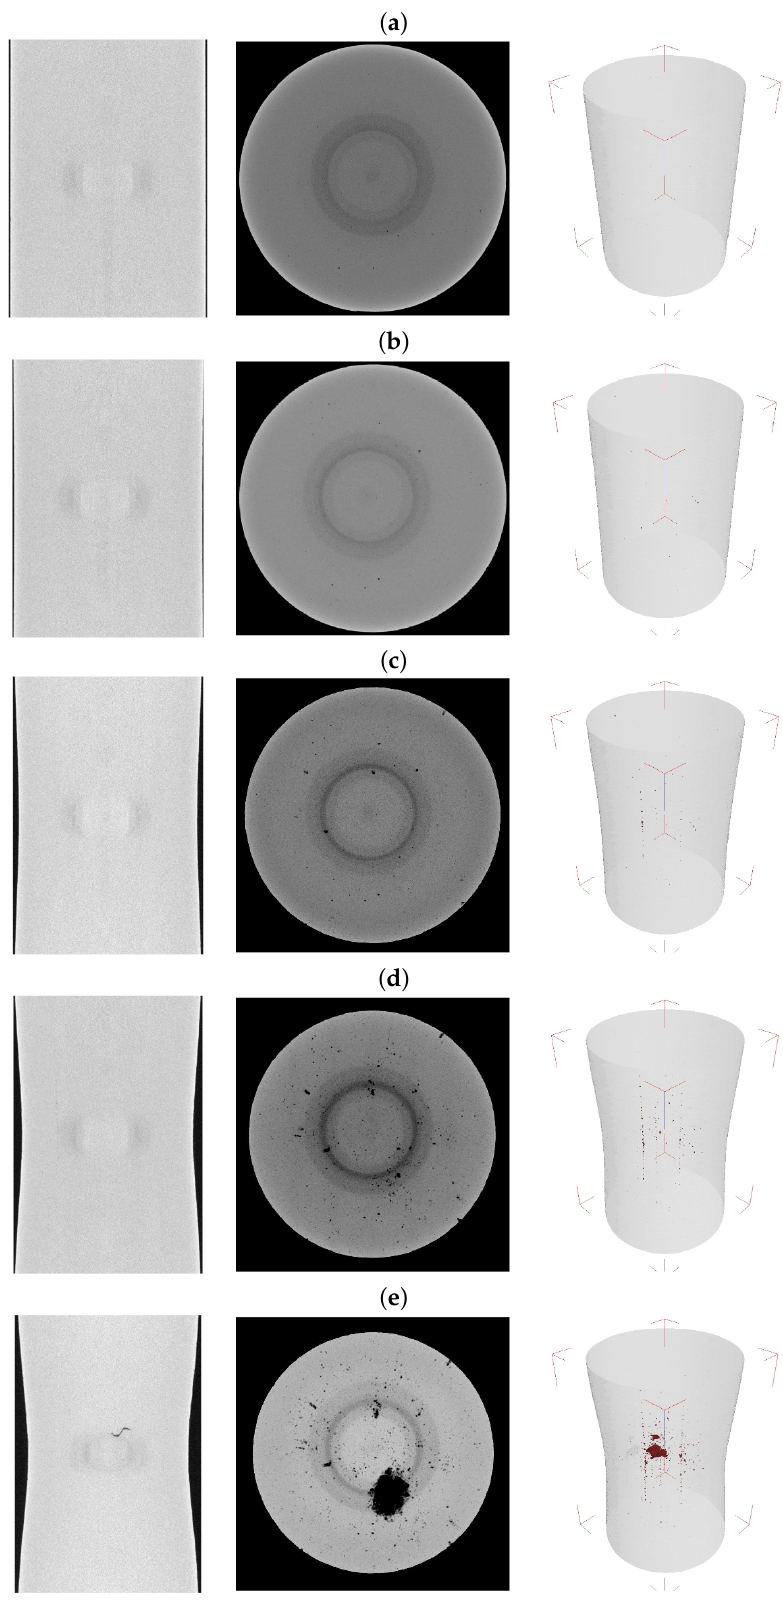
Figure 9. Results of the XRCT analysis of the necking zone for Material 1. For each step, three results are given: (I) Longitudinal section, (II) Damage projected on the floor plane and (III) Perspective of the internal damage. ( a ) Step 0: Before testing ( ε eng = 0). ( b ) Step 1: Maximum load ( ε eng = 0.076). ( c ) Step 2 ( ε eng = 0.104). ( d ) Step 3 ( ε eng = 0.118). ( e ) Step 4 ( ε eng =